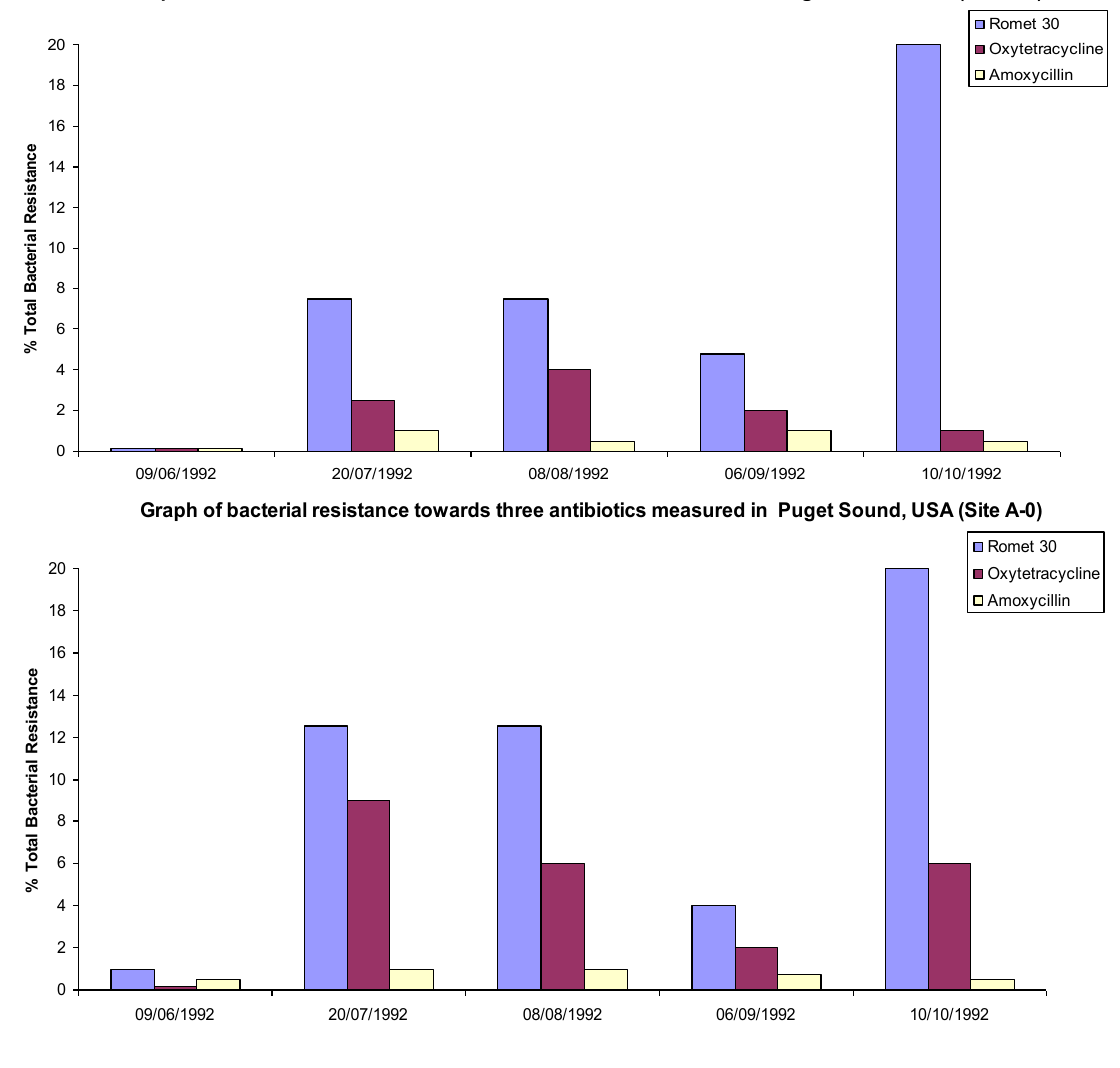
Figure 2. Graphs of % total resistance of bacteria trended with total drug sediment at a fish farm in Puget Sound, WA, USA. Adapted with permission from